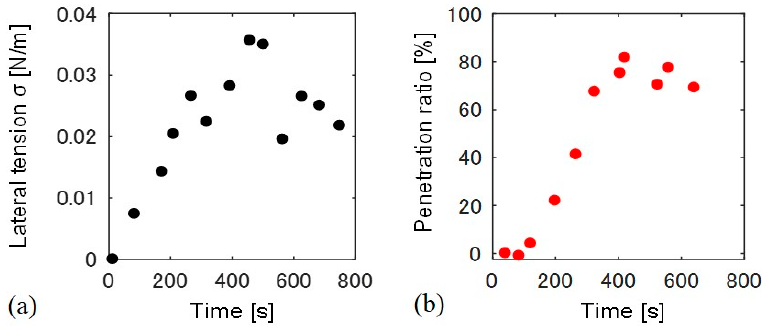
Figure 4. Time course of ( a ) lateral tension σ and ( b ) the particle penetration ratio. The time 0 s indicates the time at which hypo-osmotic solution was added to the liposome solution.